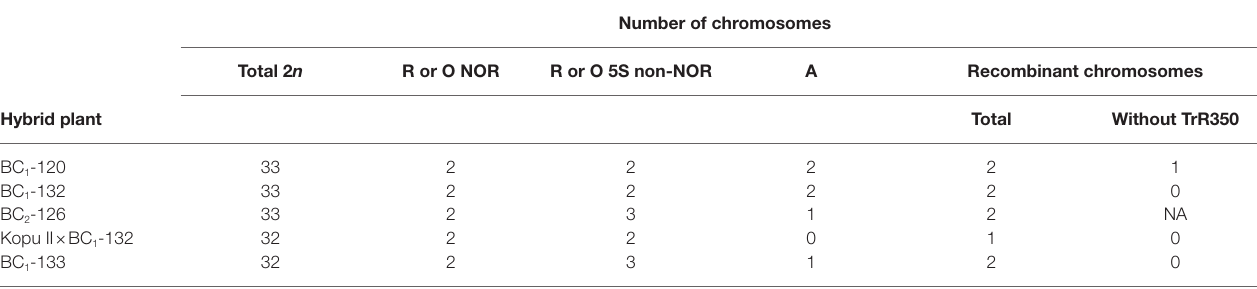
TABLE 5 | Summary of the results of FISH-GISH analyses of five interspecific hybrid plants using 18S rDNA (NOR), 5S rDNA (5S), T. ambiguum genomic DNA (A), and TrR350